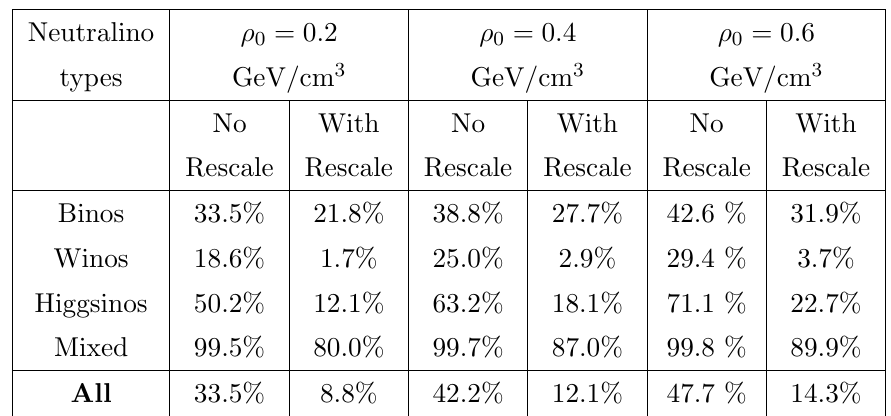
Table 9 . Fraction of points, valid after imposing the relic density upper limit, that are excluded by direct detection limits, for the di(cid:11)erent neutralino types. The exclusions are set for di(cid:11)erent values of the local DM density, which is rescaled or not by the relic